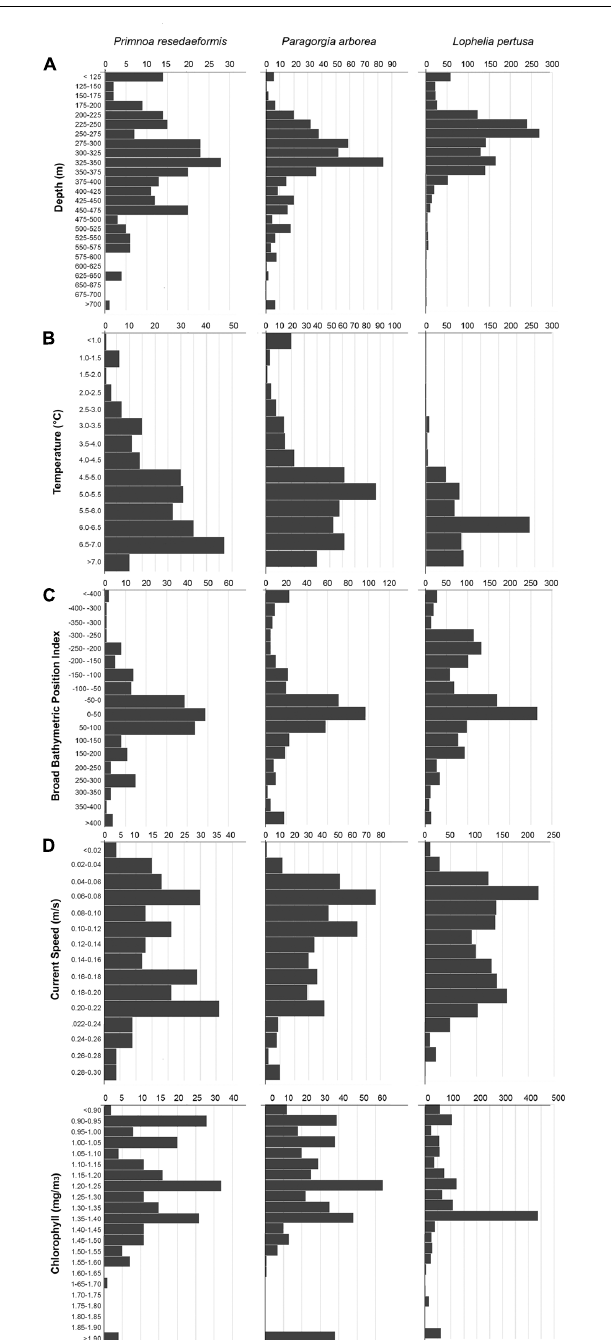
FIGURE 4 | Number of occurrences of Primnoa , Paragorgia , and Lophelia versus depth (A) , minimum temperature (B) , broad BPI (C) , mean current speed (D) , and chlorophyll a concentration (E)